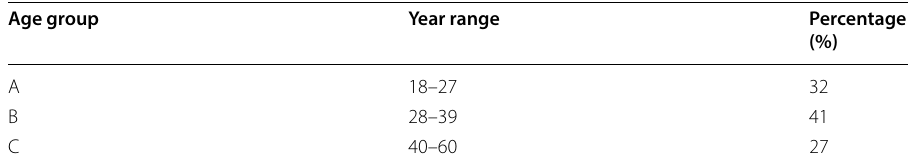
Table 4 Age groups of the